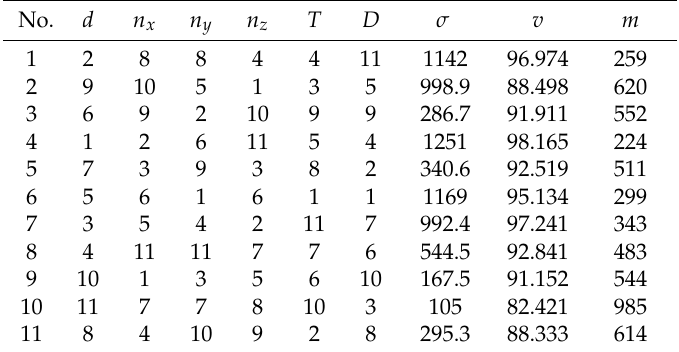
Table 8. Uniform test table and the calculation and finite element analysis results for the improved storage structure with a square column